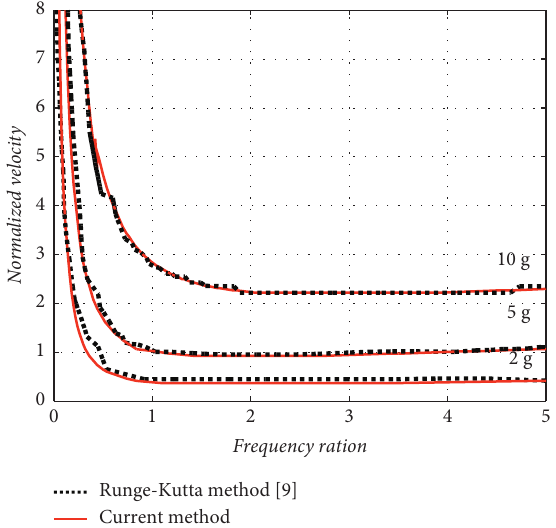
Figure 5: DDBCs of a packaging system with cubic stiffness ob- tained from a simulation and experiment at 2 g and 5 g .